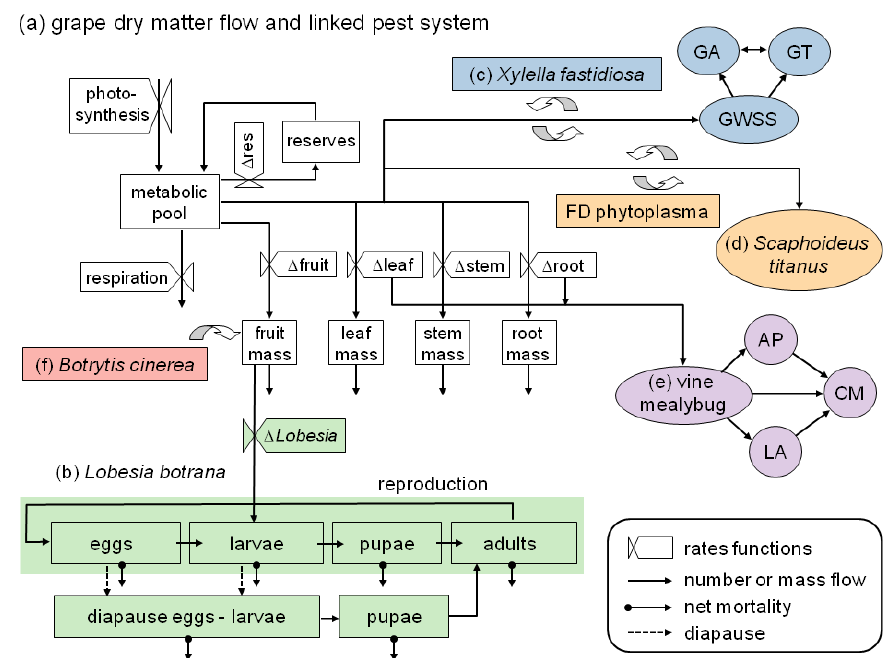
Figure 1. The grape system model including major pests, vectors, and diseases that have been modeled and included in the extant or developing system. ( a ) Dry matter flow in grapevine [38,39]; and ( b ) the linkage of European grapevine moth ( Lobesia botrana ) life-stages including diapause induction and termination [13,40]. Linkages of three vascular feeding Homoptera; ( c ) the glassy-winged sharpshooter (GWSS) with its natural enemies the parasitoids Gonatocerus ashmeadi (GA) and G. triguttatus (GT), and the transmission of the bacterium Xylella fastidiosa that causes Pierce’s disease [41]; ( d ) the leafhopper Scaphoideus titanus and the transmission of the phytoplasma that causes flavescence dorée disease (currently being modeled) [42]; and ( e ) the vine mealybug with its natural enemies the parasitoids Anagyrus pseudococci (AP) and Leptomastidea abnormis (LA), and a coccinellid predator, Cryptolaemus montrouzieri (CM) [43]; ( f ) Linkage of the fungus Botrytis cinerea that causes grey mold disease developed by González-Domínguez et al. [44]. (Figure modified from [13]).